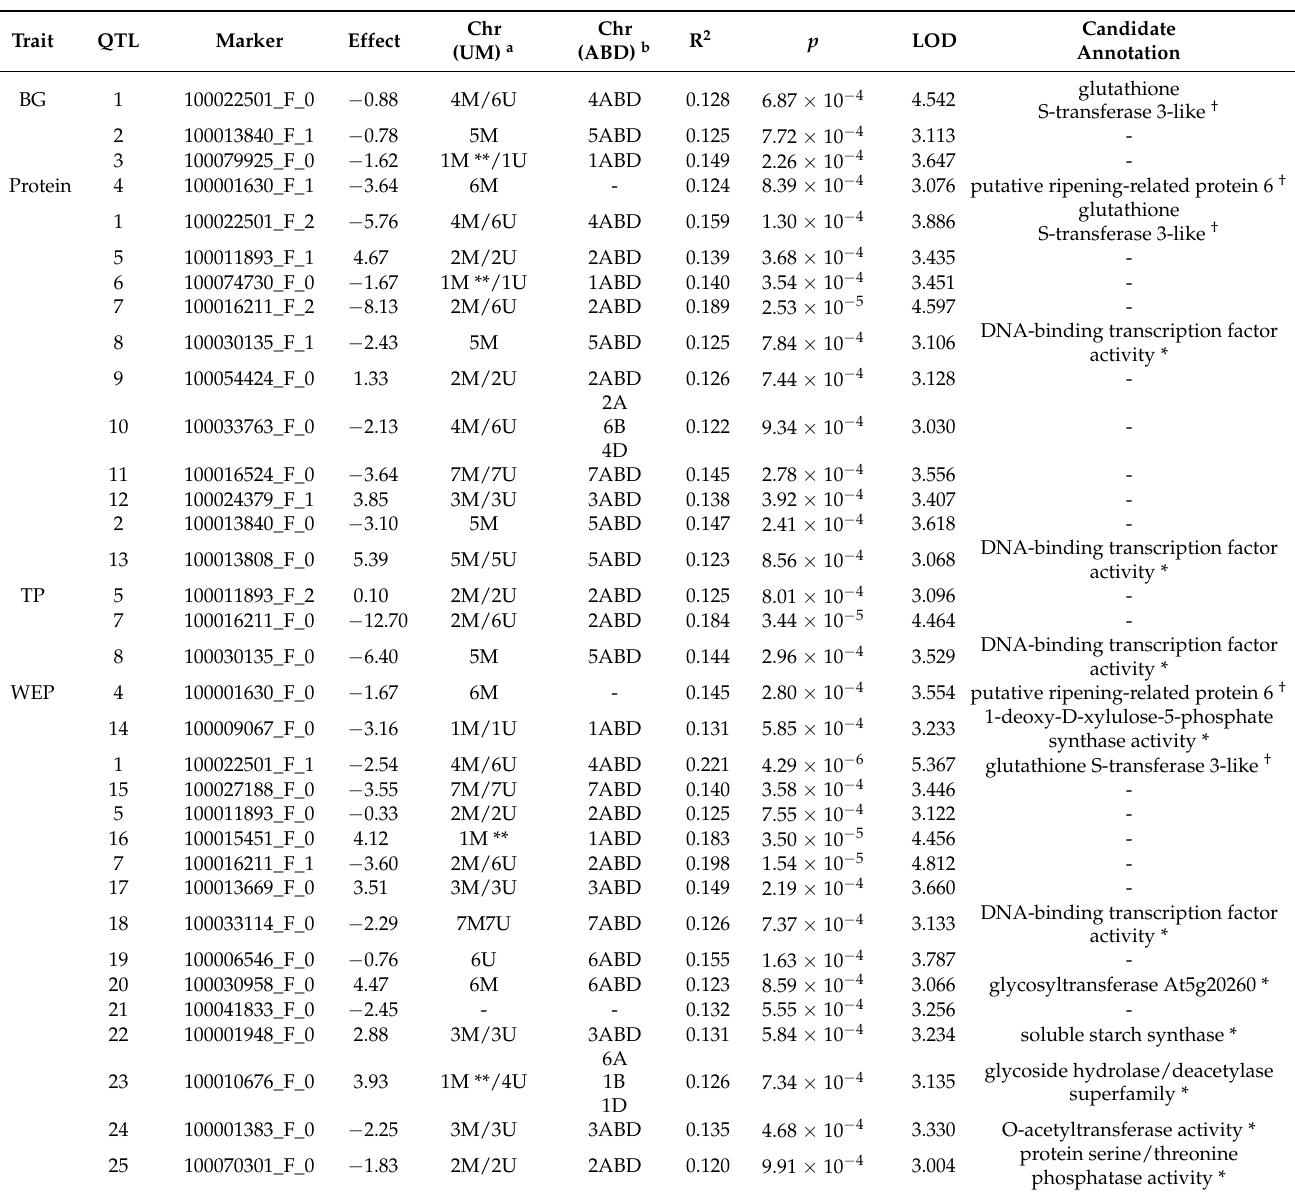
Table 3. Marker-trait associations, DArTSeq markers, marker locations on the chromosomes of Aegilops (UM) and wheat (ABD), and p values on chromosomal regions associated with dietary fiber trait components [ β -glucan (BG), total-pentosan (TP) and water-extractable pentosan (WEP)], and grain protein content. GWAS analysis was performed for each individual year, considering all four quality traits estimated for both years as a covariate, only significant QTLs in both environments were